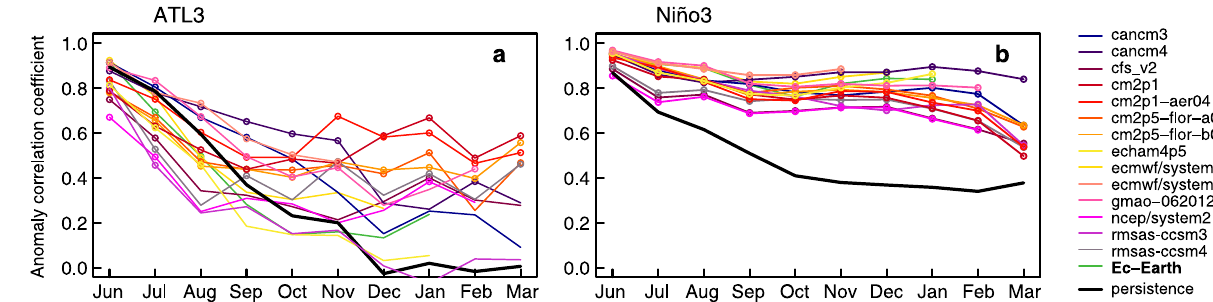
Fig. 1 Multi-model assessment of seasonal prediction skill in the Tropical Atlantic and Paci fi c. a Prediction skill (evaluated by the anomaly correlation coef fi cient; ACC) of ATL3 SST in each of the prediction systems in Supplementary Table 1. Skill is evaluated against HadISST v1.1, for the period 1981 – 2011. ACC values associated with persistence in observations are indicated by the black line. b The same but for the prediction skill of Niño3 SST. Empty circles indicate when the prediction skill is statistically signi fi cant ( p < 0.05, see “ Methods ”